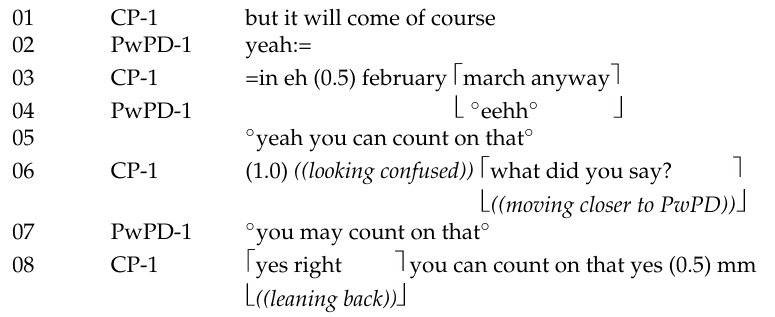
Figure 1. Impaired speech, problem quickly resolved.